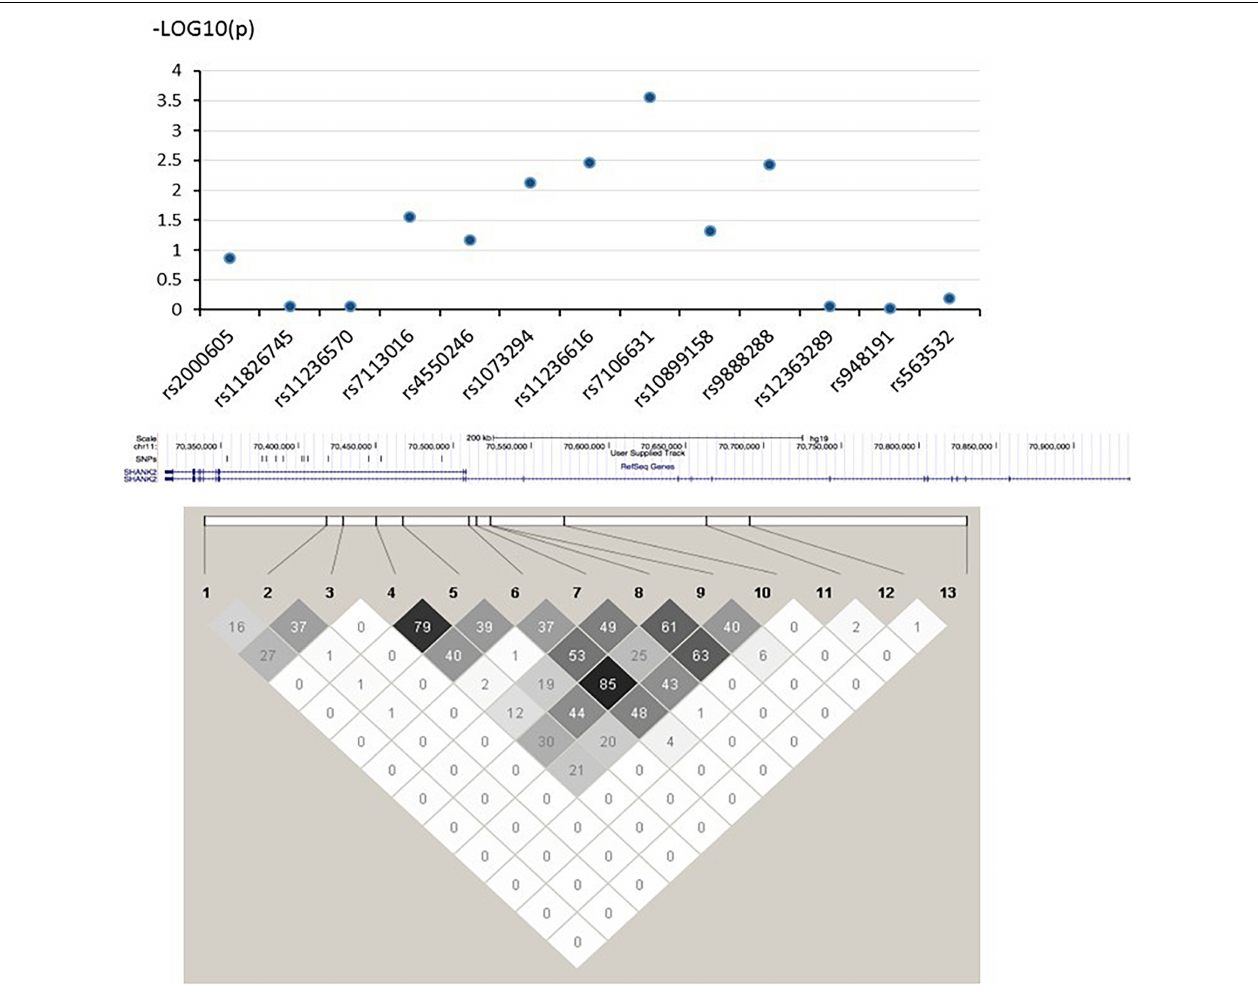
FIGURE 1 | –log (P) graph and pair-wise LD structure of selected SNPs in SHANK2 . Above graph shows association analysis results of 13 SNPs; each blue dot represents the –log ( p -value) of each SHANK2 SNP. Below graph represents the pair-wise LD structure of SNPs in SHANK2 ; the number in each cell is the R 2 between two SNPs with darker color representing stronger R 2